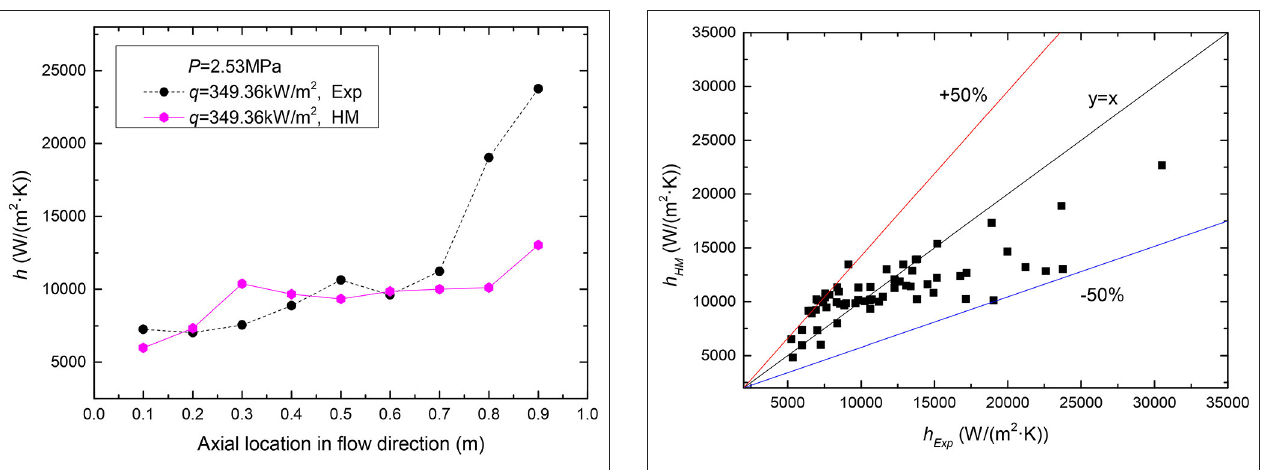
FIGURE 12 | The relative error at high pressure.